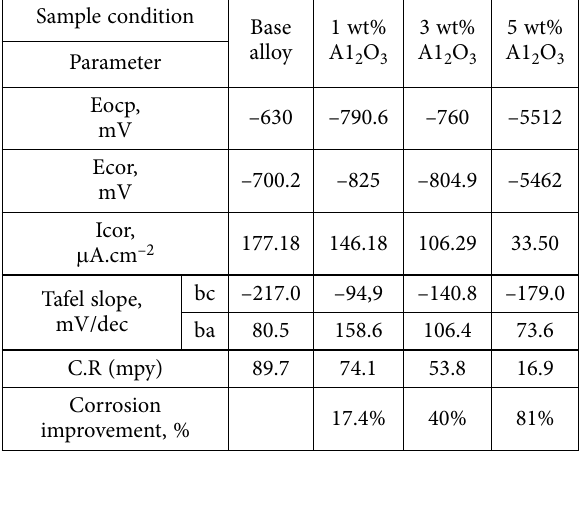
Table 4. Eocp values and corrosion parameters results of base alloy and nanocomposites